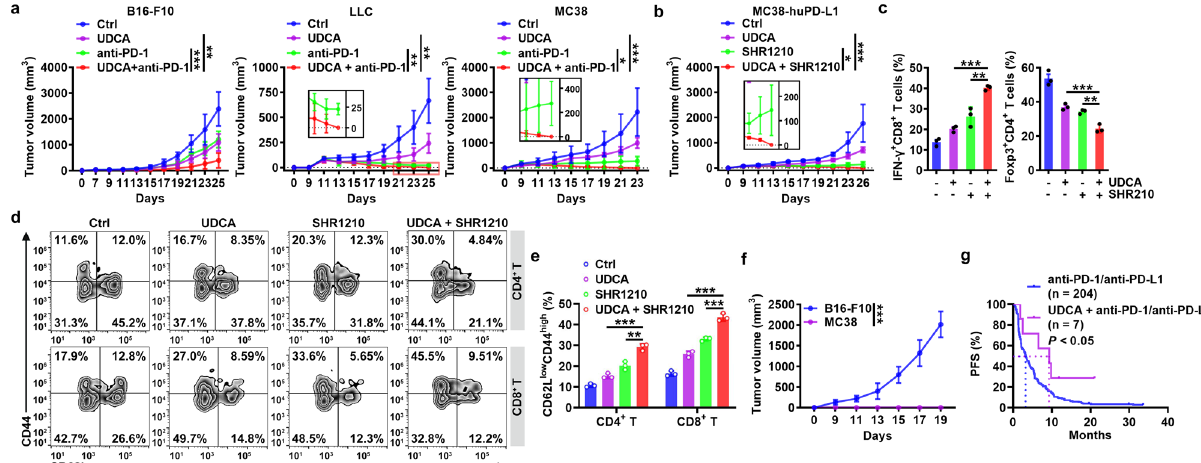
Fig. 7 UDCA enhances the antitumor effects of anti-PD-1. a Tumor sizes in B16-F10, LLC and MC38 tumor-bearing mice that received oral administration of 30 mg kg − 1 Ursofalk (UDCA) every other day along with i.p. injection of 50 μ g anti-PD-1 every 4 days. b – e Tumor sizes ( b ) and FC analysis (on day 18) of IFN- γ + CD8 + T and Foxp3 + CD4 + T cells among TILs ( c ); FC ( d ) and statistical ( e ) analyses (on day 33) of memory T cells in peripheral blood of MC38- huPD-L1 tumor-bearing mice that received oral administration of 30 mg kg − 1 UDCA every other day along with intravenous injection of 50 μ g SHR1210 every 4 days. f Tumor sizes of tumor-free mice in ( b) after rechallenge with B16-F10 or MC38-huPD-L1 cells. g PFS curve for NSCLC patients who received anti-PD-1 or anti-PD-L1 therapy with or without UDCA treatment. Representative results from three independent experiments are shown (mean and s.d.) ( n = 5 in ( a , b , f ); n = 3 in ( c – e ). * P < 0.05; ** P < 0.01; *** P < 0.001 (unpaired two-tailed Student ’ s t test except for log-rank test in g ; mean and s.d.). See Source Data fi le for the exact P